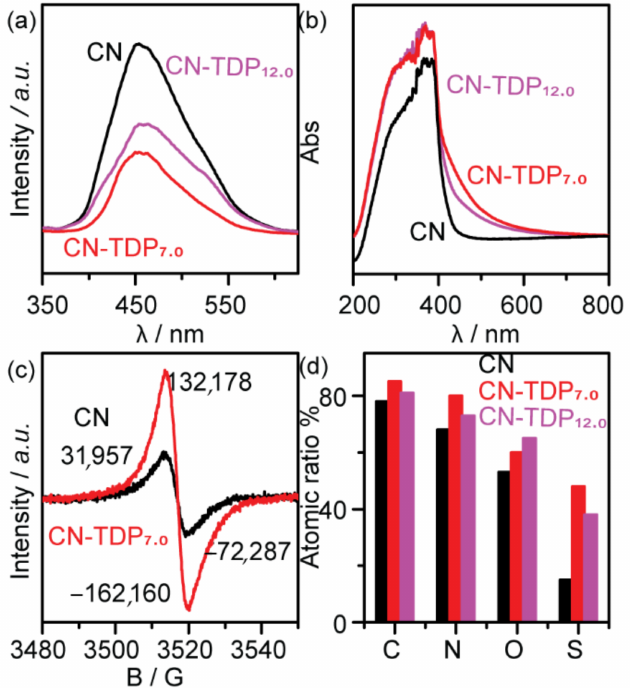
Figure 3. ( a ) photoluminescence spectra, ( b ) UV-Visible DRS, ( c ) EPR spectra in the dark at RT for CN and CN-TDP 7.0 samples. ( d ) Elemental analysis and C/N molar ratio for all samples under visible light ( λ > 420 nm).